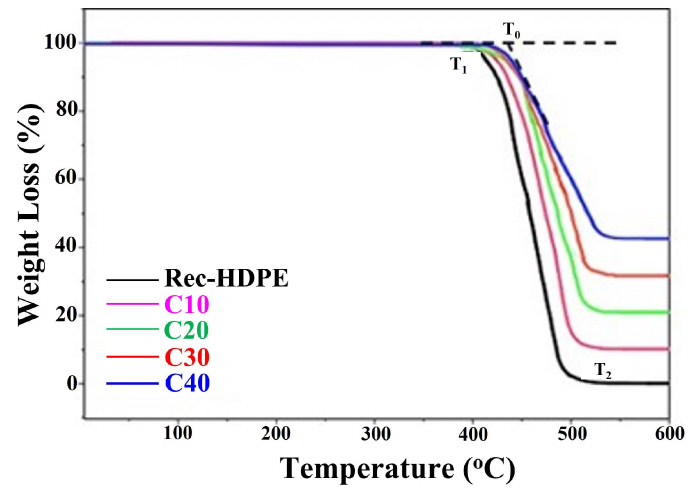
Figure 9. TG curves of the recycled HDPE and composites.